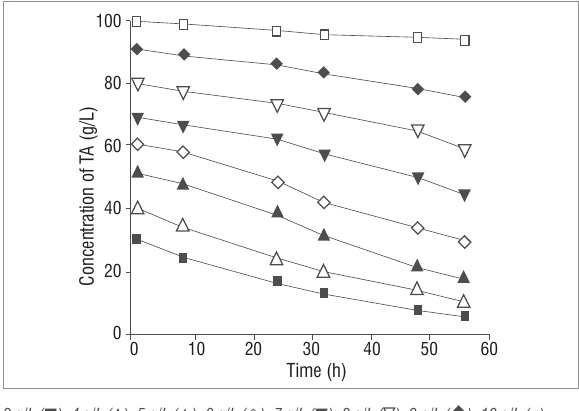
Figure 6: Time course of terephthalic acid (TA) degradation by Arthro bacter sp.0574 for different initial concentrations of